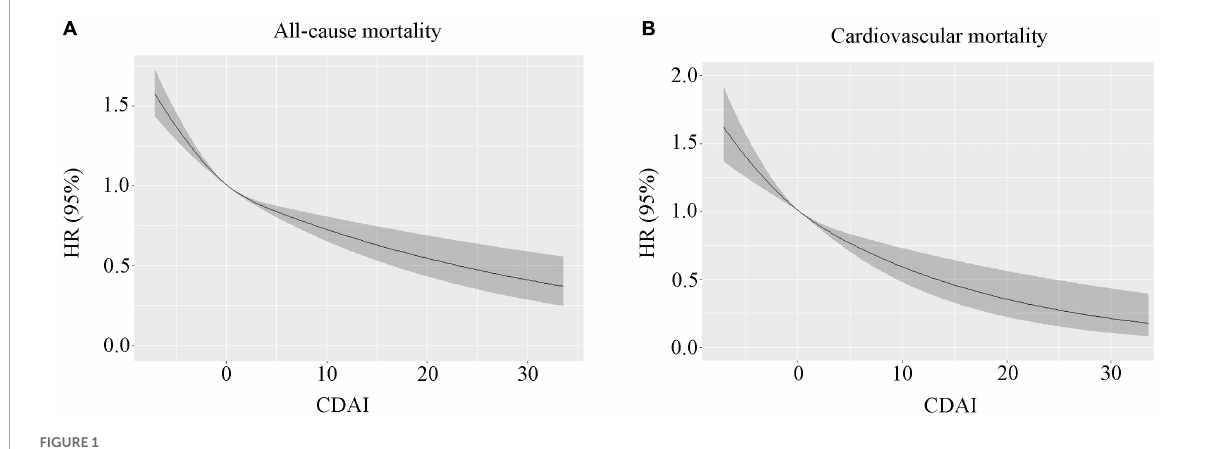
FIGURE1 (A) The correlation between the continuous CDAI and all-cause mortality was demonstrated using generalized additive models. (B) The correlation between continuous CDAI and cardiovascular mortality is demonstrated using generalized additive models. CDAI, composite dietary antioxidant index.